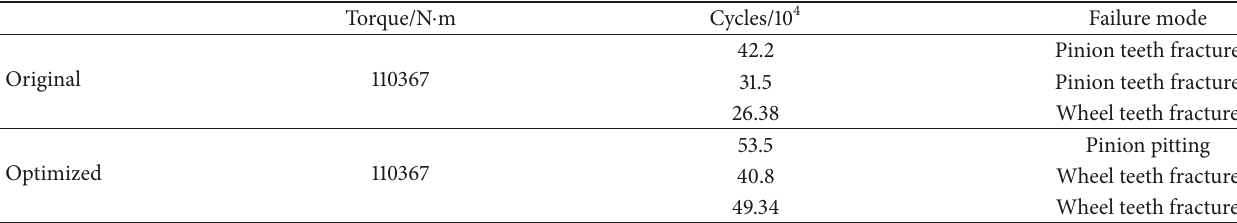
Table 5: Results of the bench